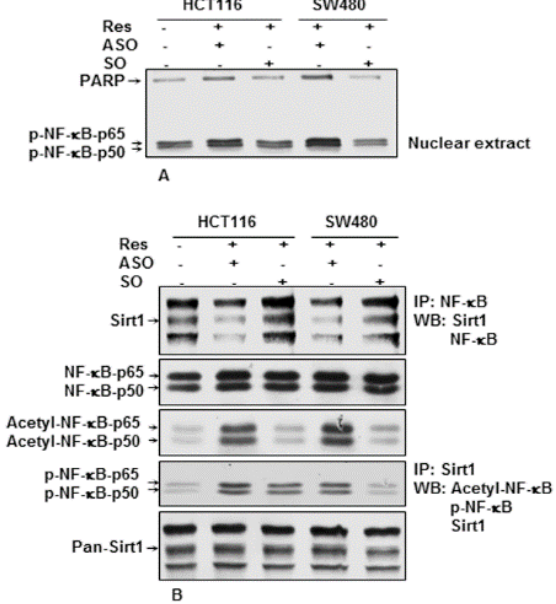
Figure 6. Effects of resveratrol or/and ASO against Sirt1 on NF- κ B signaling pathways in